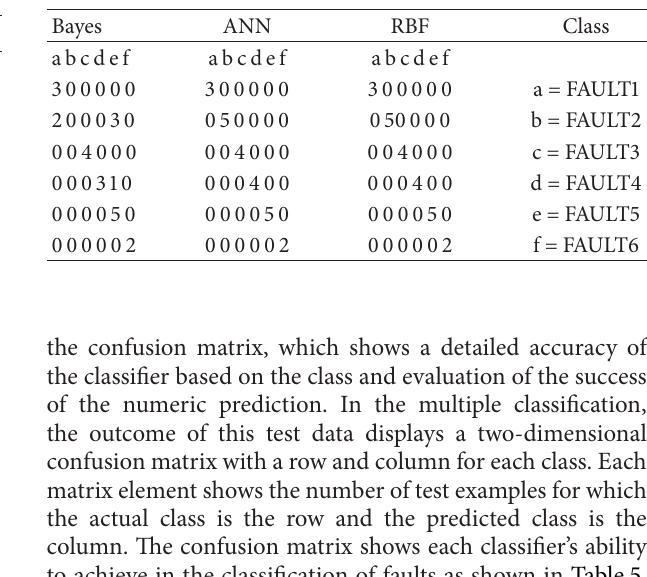
Table 5: Confusion matrix for different